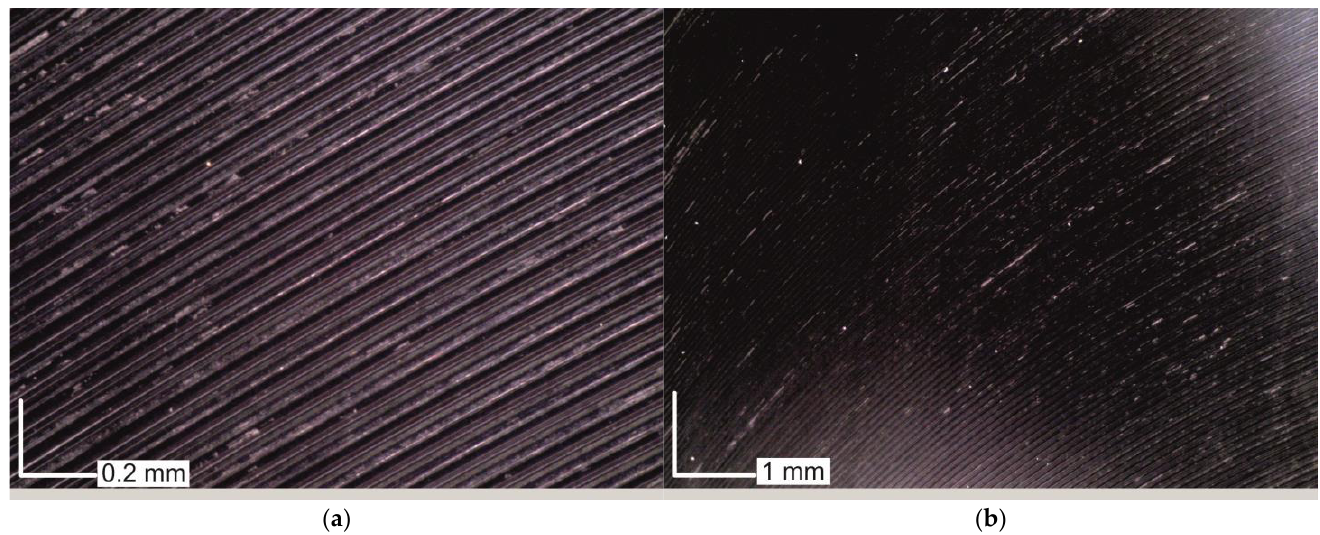
Figure 11. Surface after machining with the use of cooling: ( a ) 100 times magnification; ( b ) 200 times magnification.